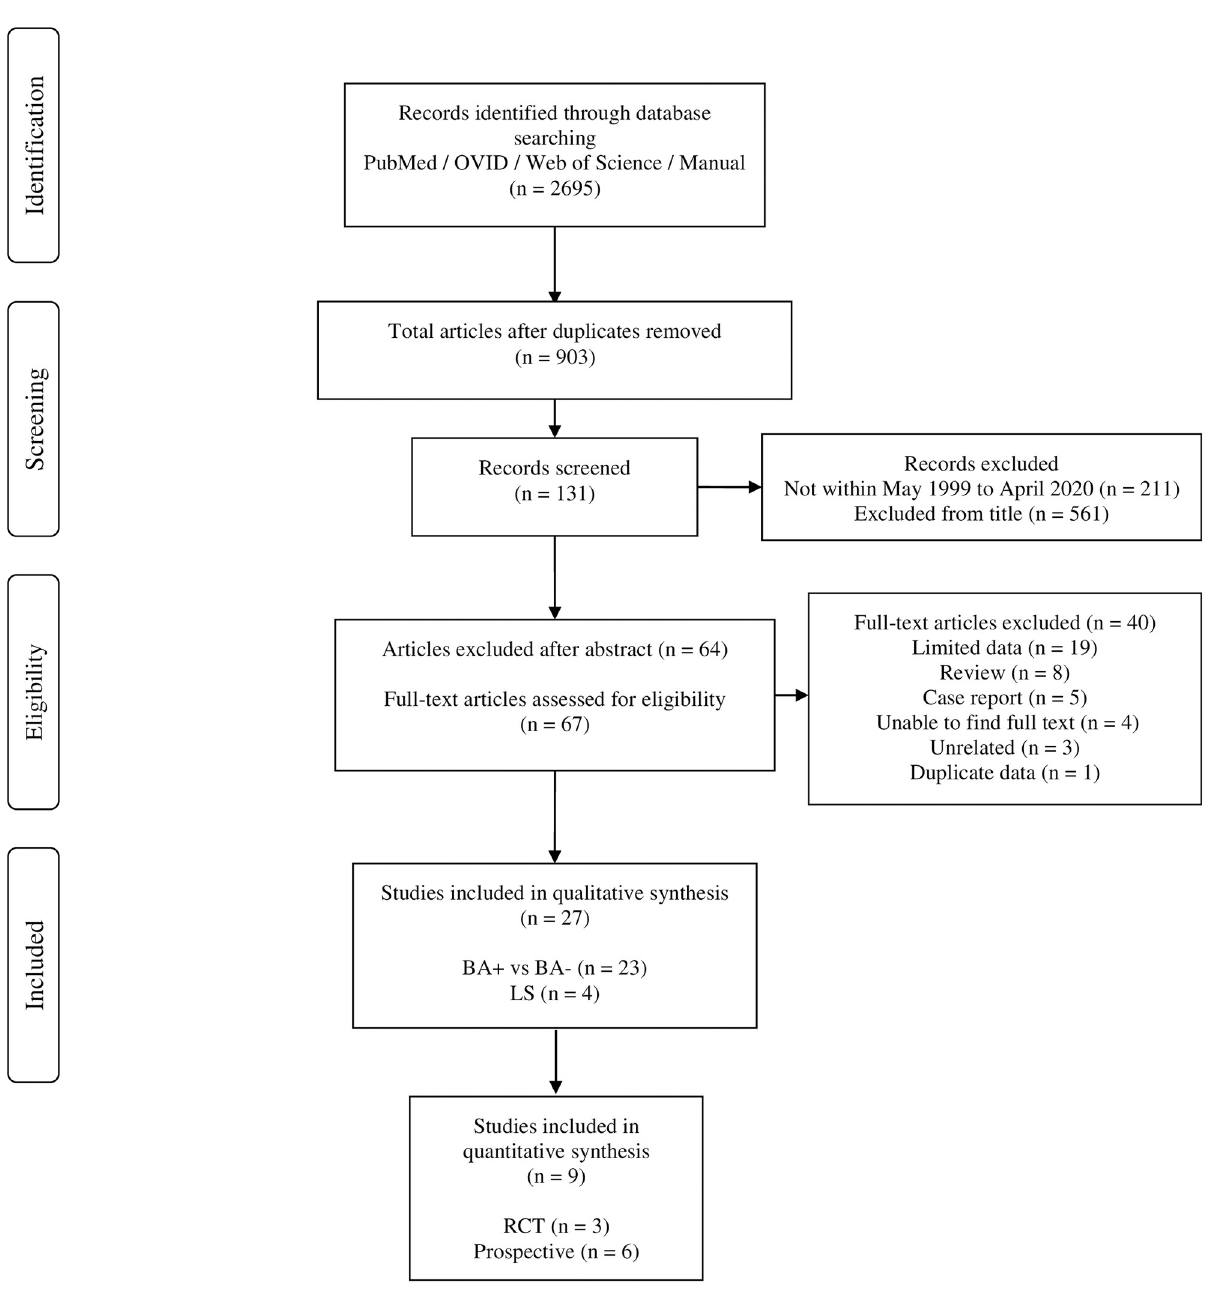
Fig 1. Process of data collection in accordance with the PRISMA statement for systematic